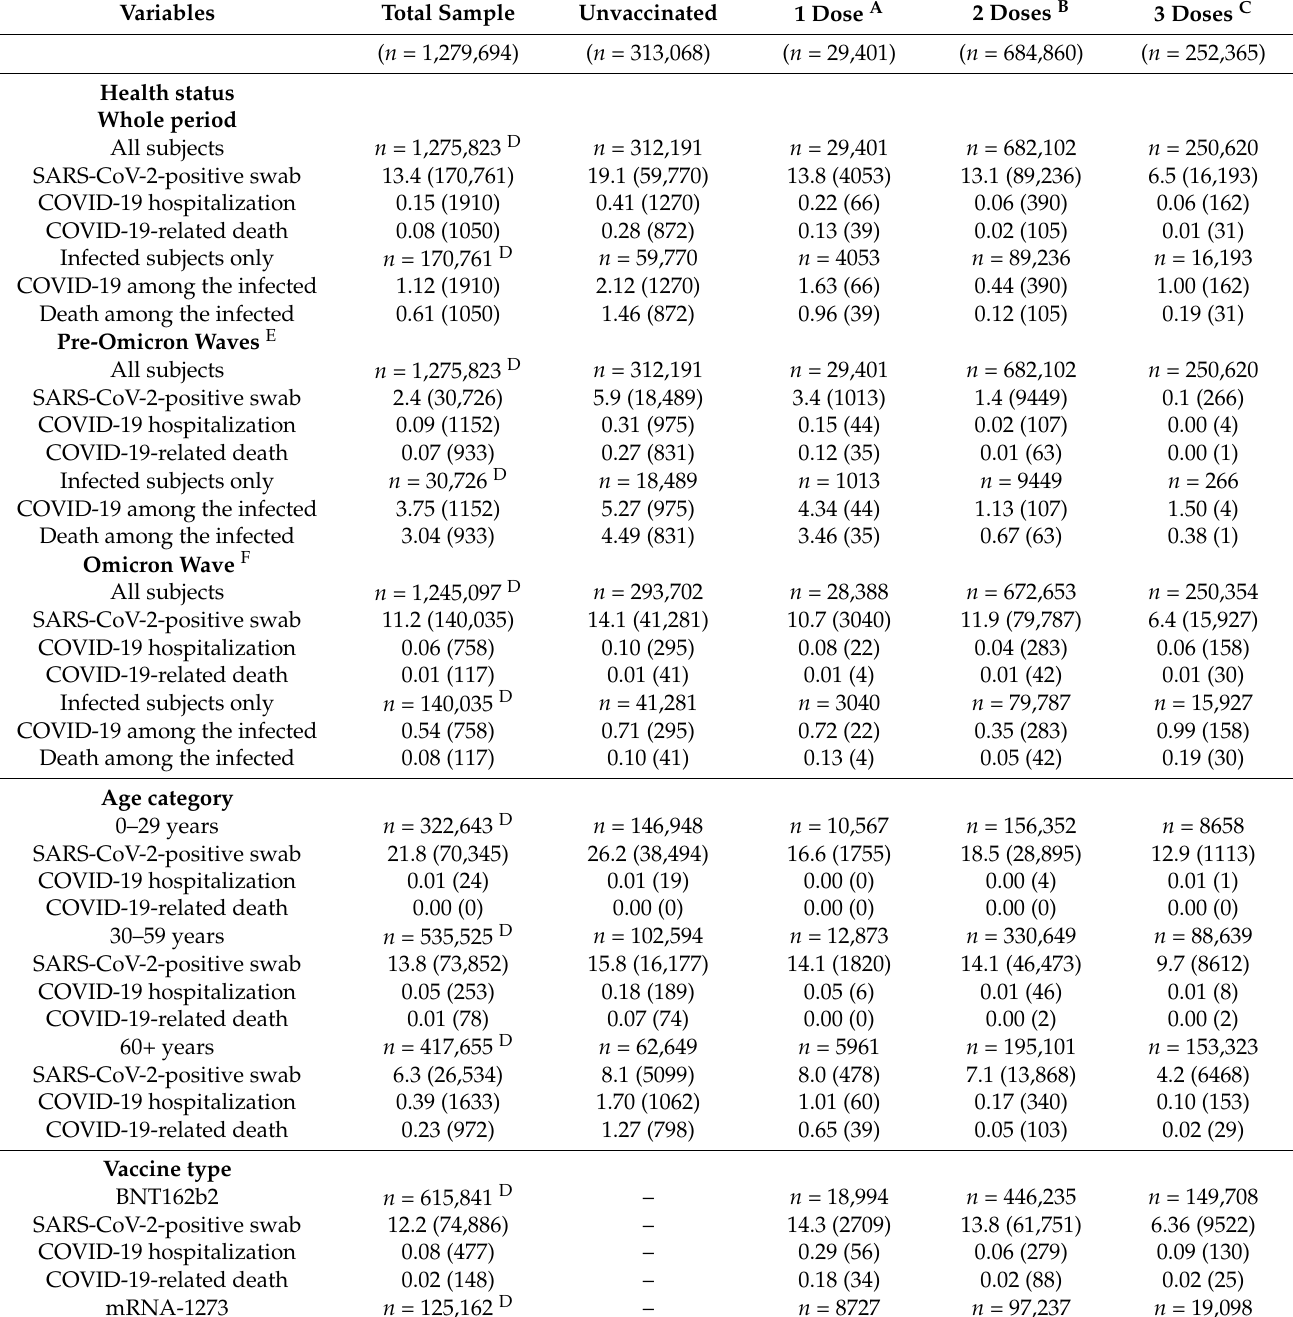
Table 2. Main outcomes, overall, by vaccine status, vaccine type, and age